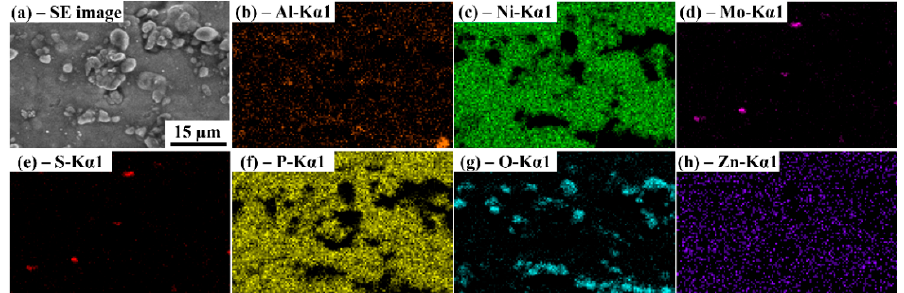
Figure 8. Energy dispersive spectroscopy mapping of the composite coating surface with 3 g/L Al 2 O 3 and 1 g/L MoS 2 powder concentration indicating (a) SE image, elements (b) Al, (c) Ni, (d) Mo, (e) S, (f) P, (g) O, and (h) Zn.